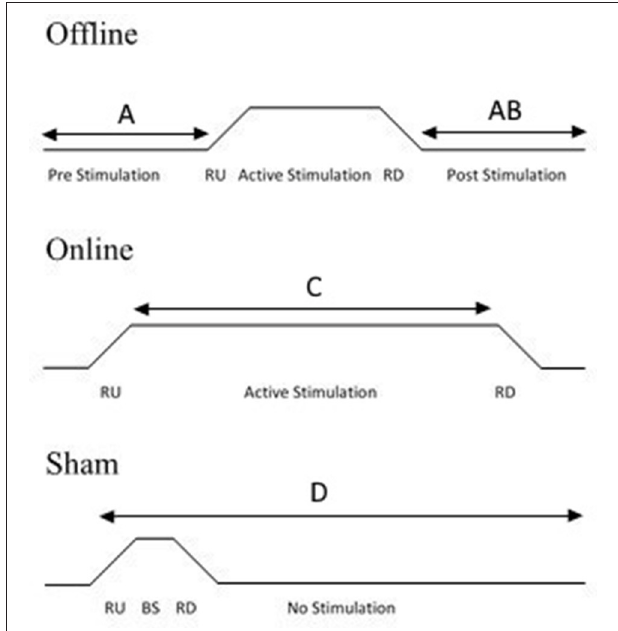
FIGURE 2 | Diagram illustrating experimental protocols. Offline stimulation involves a period of pre-stimulation in which a task may be completed, followed by a period of stimulation and then a post-stimulation task (A) or a post-stimulation task only (B) . Online stimulation involves participants receiving stimulation during the task (C) . For sham stimulation, the task can be undertaken according to either online or offline protocols. Sham stimulation involves the current ramping up (RU), followed by a brief stimulatory (BS) period which is usually 3–5% of the active session duration, followed by a ramping down of the current. The current then remains off for the rest of the session. The task can be applied at any point during the session (D) , depending on whether an online or offline protocol is